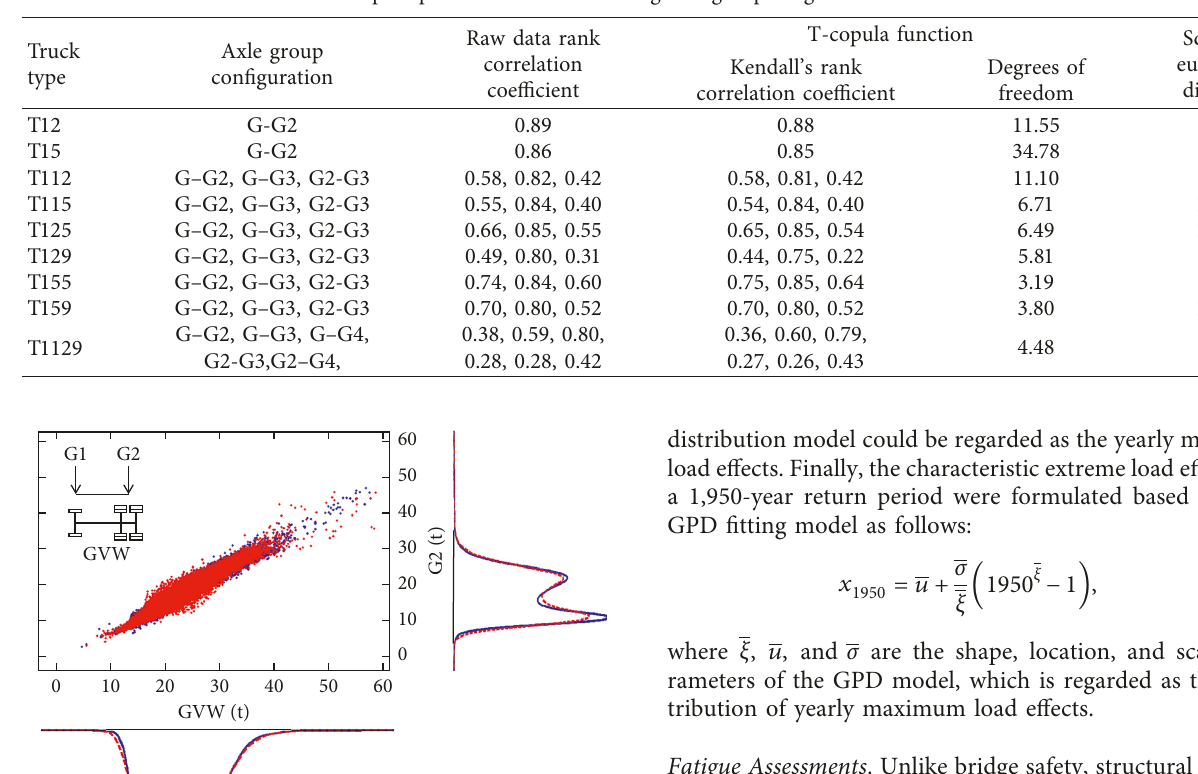
Table 5: T-copula performance in describing axle group weight and GVW correlation.